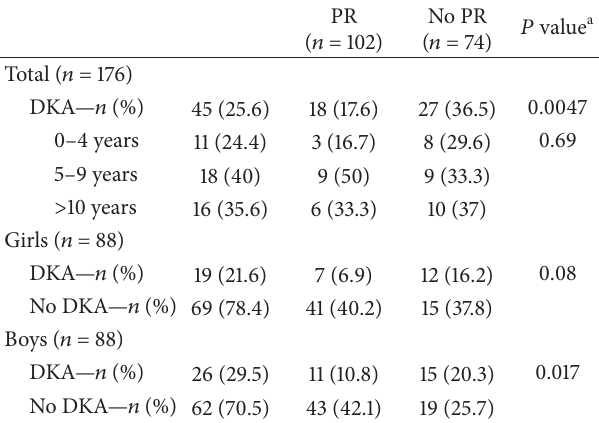
Table 2: Subgroup analysis of DKA